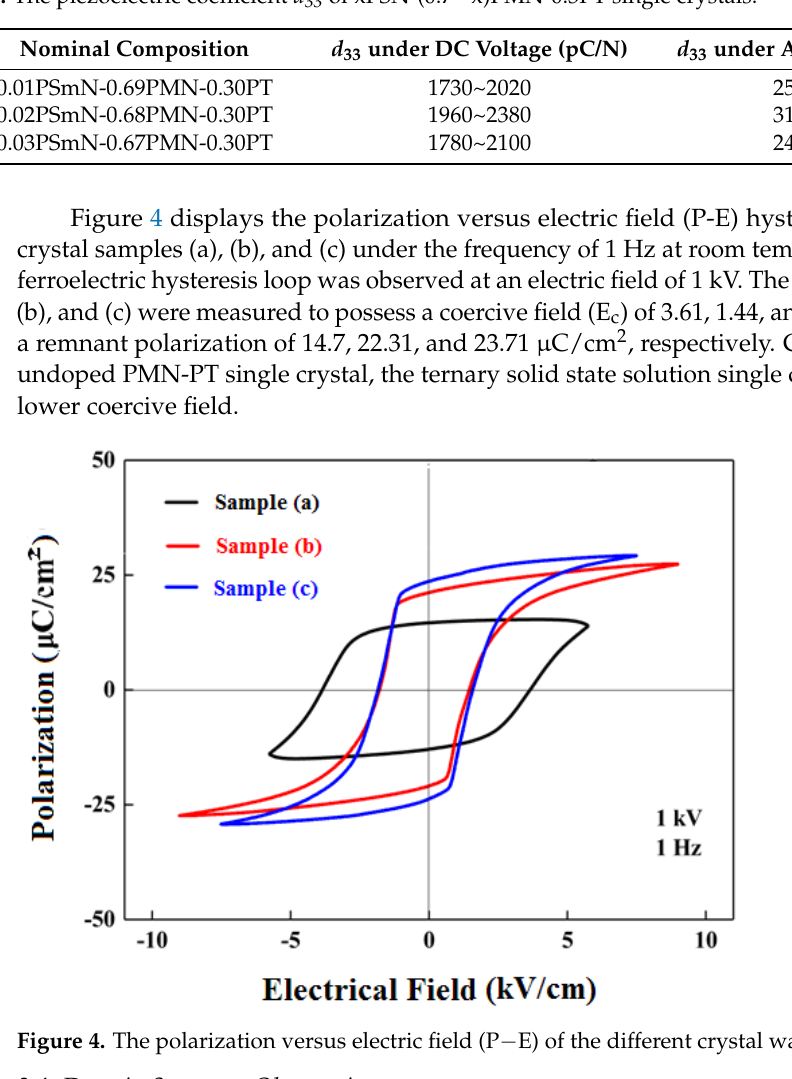
Figure 5. Bright-field TEM microstructure images of the 0.02PSmN-0.68PMN-0.30PT single crystal under ( a , b ) alternating current polarization (ACP); ( c , d ) direct current polarization (DCP). The deflection direction and the distribution of electric domains in the samples were measured by differential phase contrast (DPC). The results of DPC analysis on the crystals are shown in Figure 6, in which colors represent different directions of the electric field, and the arrows represent the directions of the electric fields. It is observed that the domain